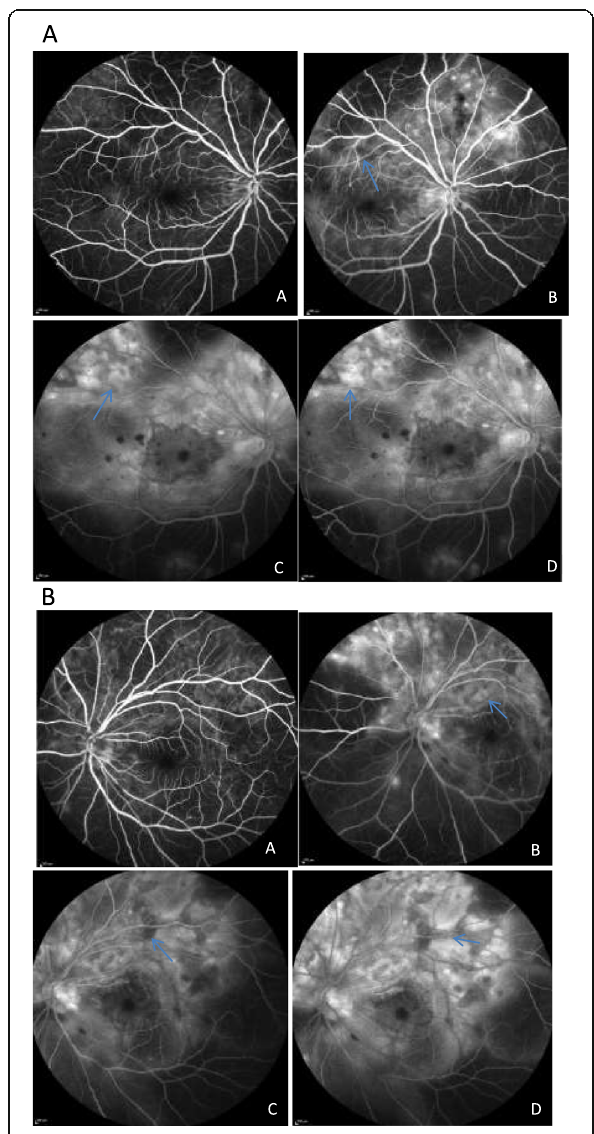
Fig. 3 a Fluorescein angiography of the right eye at 1 min ( a ), 3.30 min ( b ), 11 min ( c ), and 15.30 min ( d ) showing early blocked fluorescence with pin-point leakage in the middle phase with late areas of placoid hyperfluoresence and with persistent areas of hypofluoresence corresponding to the hemorrhages. b Fluorescein angiography of the left eye at 1 min ( a ), 5 min ( b ), 10 min ( c ), and 16 min ( d ) showing early blocked fluorescence with pin-point leakage in the middle phase with late areas of placoid hyperfluoresence, and with persistent areas of hypofluoresence corresponding to the hemorrhages